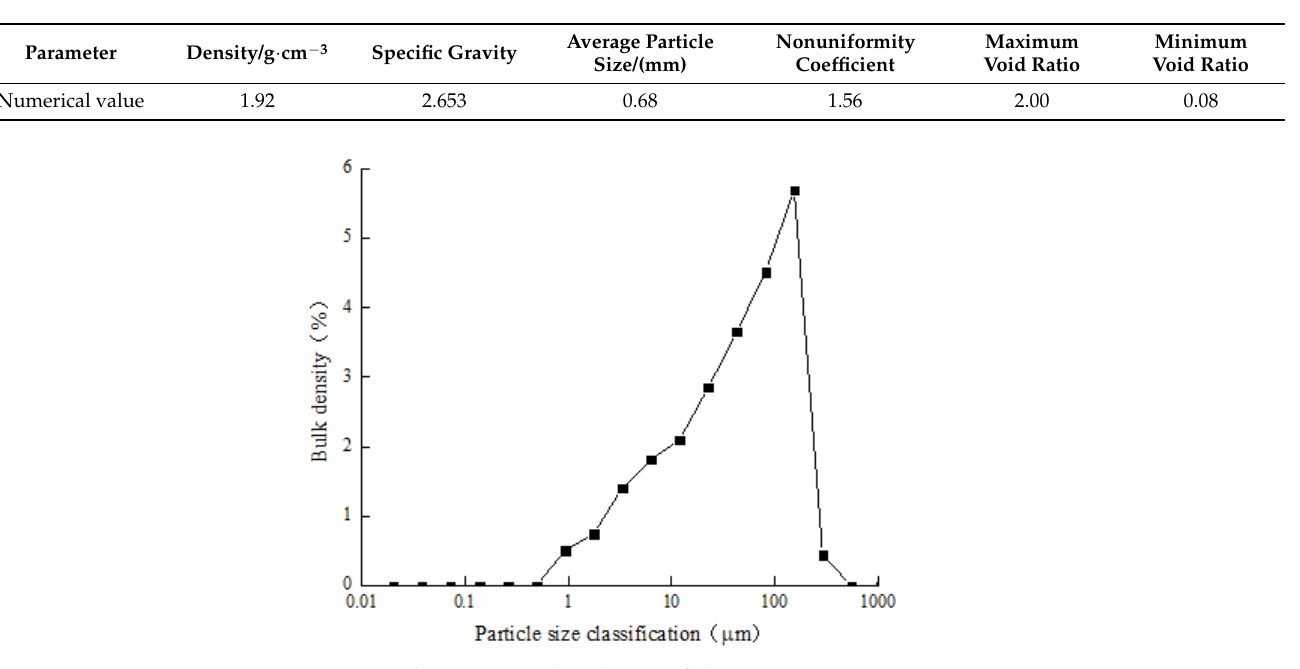
Table 2. Physical parameters of Fujian standard sand.